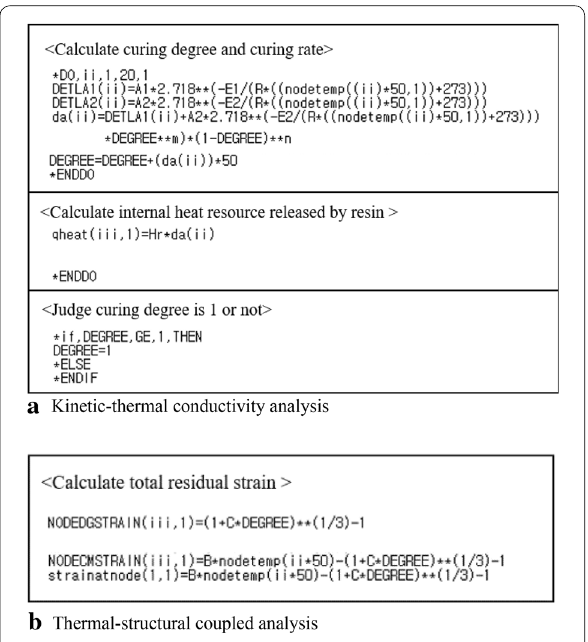
Figure 21 APDL code to simulate curing analysis